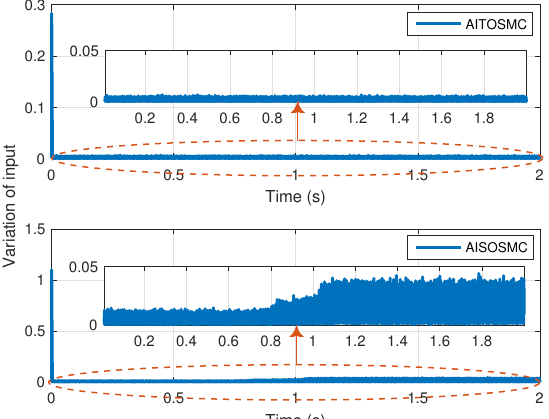
Figure 10. Time history of total variations for the AISOSMC and the proposed